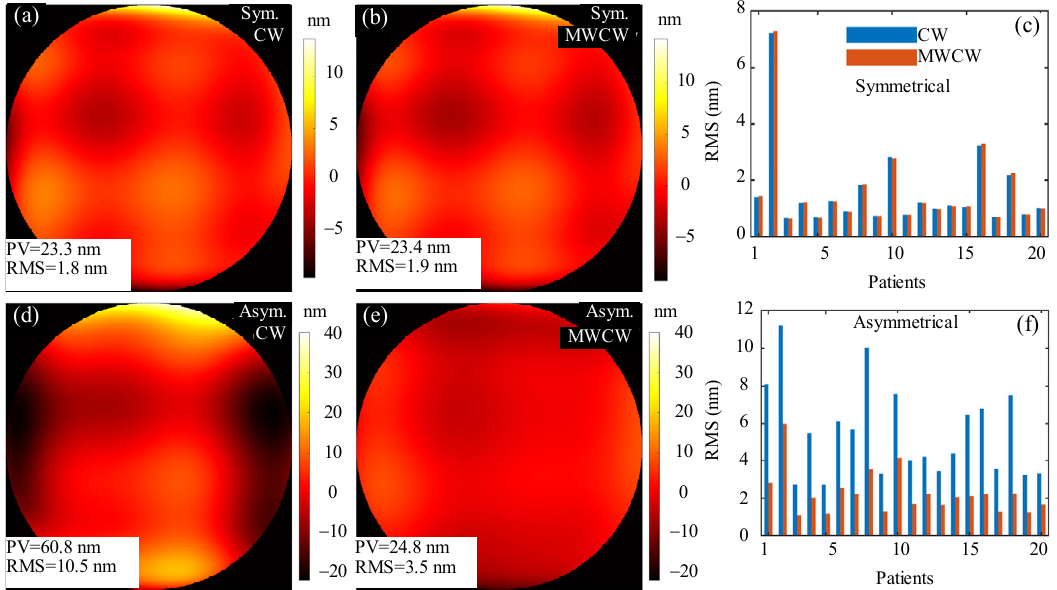
Fig. 5 Performance of two methods used for clinical ocular aberrations: wavefront errors of Patient #8 obtained with (a) CW and (b) MWCW methods for symmetrical, and with (d) CW and (e) MWCW methods for asymmetrical S (  ); RMSs of wavefront errors obtained with 20 sets of aberrations for (c) symmetrical and (f) asymmetrical S ( 